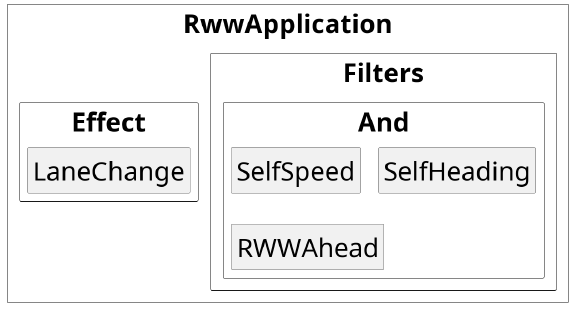
Figure 3. Road works warning app configuration.